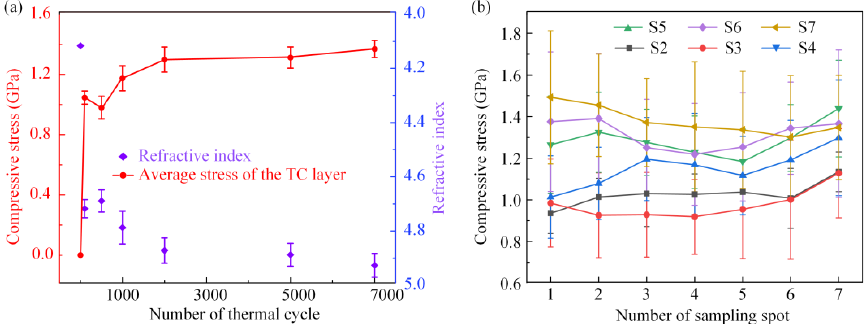
after thermal cycles; ( b ) stress distributions of the TC layers in the specimens